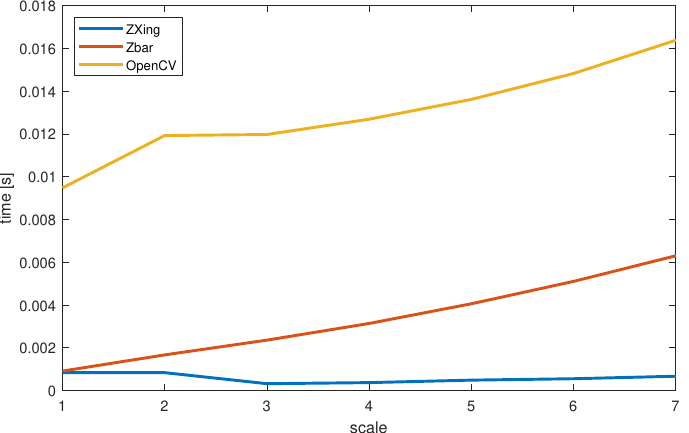
Figure 12. Recognition time for the simple QR code decoding for the two QR code readers. Probably, the latter fills the gap between simulation and real life image acquisition. It is highly unlikely that a QR code would be registered by a perfectly matched sensor grid, so those repeating peak values in OpenCV results, along the integer axis, should be considered as theoretical, not actual